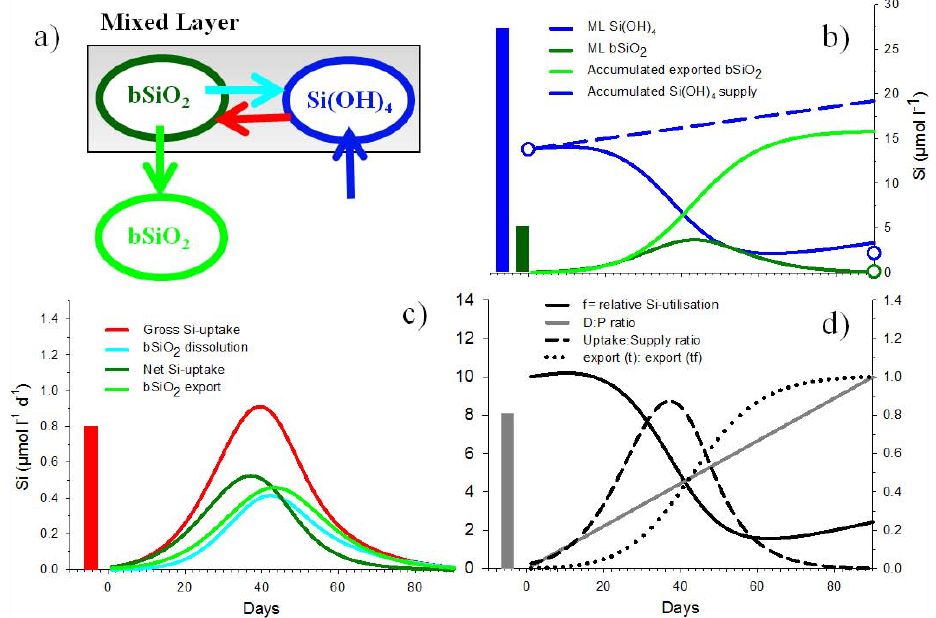
Fig. 5. (a) Schematic representation of the box model ( = 100m deep mixed layer). Round boxes represent pools of silicic acid in the mixed layer (blue), biogenic silica in the mixed layer (dark green), and accumulated exported biogenic silica below the mixed layer (light green). Arrows stand for processes exchanging Si between the pools: gross Si-uptake (red arrow), bSiO 2 dissolution (cyan arrow), bSiO 2 export (green arrow), and vertical Si(OH) 4 supply (blue arrow). (b, c, d) Model outputs for the PFZ simulation. Panel (b) simulated concentrations of Si(OH) 4 and bSiO 2 in the mixed layer, accumulated exported bSiO 2 , and accumulated Si-supply to the mixed layer. The initial and final estimations are indicated using empty dots with the corresponding colors (Table 2). Panel (c) simulated gross Si-uptake, bSiO 2 dissolution, net Si-uptake, and bSiO 2 export. (d) Simulated Si-uptake:supply ratio (left y-axis), relative Si(OH) 4 utilization (right y-axis), export(t):export(tf) ratio (right y-axis) and D : P ratio (right y-axis). V max = 0 . 41, K Si = 4µmoll − 1 , k export = 0 . 13, and subsurface Si(OH) 4 (right y-axis) supply = 540 mmol m − 2 . Brzezinski et al. (2001) is the only time series across the whole productive period describing the silicon biogeochemical dynamics in the Polar Front Zone in the Pacific Sector (PFZ between 61°S and 52°S). The vertical bars in the (a) , (b) , and (c) represent the range for silicic acid and biogenic silica concentrations (respectively the blue and green vertical bars in b ), the gross Si-uptake (red vertical bar in c ), and the D : P ratio (gray vertical bar in d